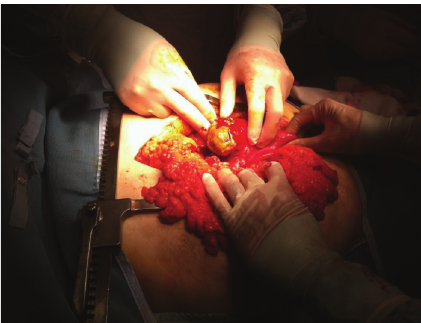
Figure1:Intraoperativefindings:perforatedjejunaldiverticulawith impacted